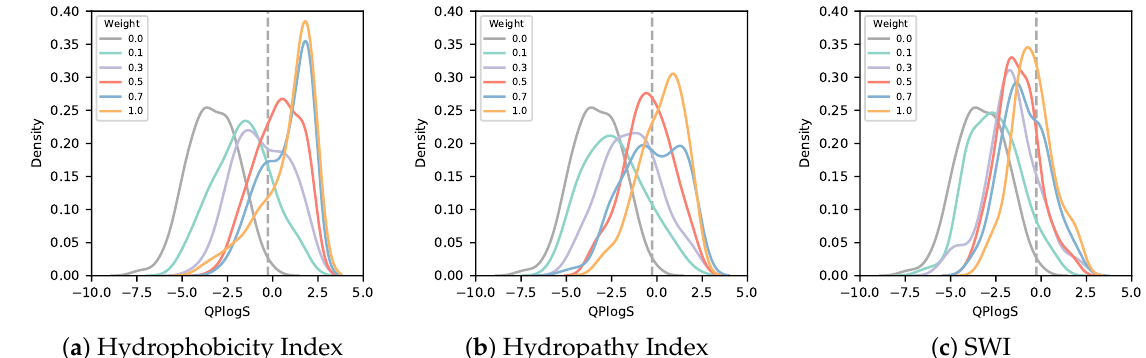
Figure 3. Distribution of logS for various weights of sequences designed in AfDesign using three solubility indices. The logS of sequences designed in AfDesign using the Hydrophobicity Index ( a ), Hydropathy Index ( b ), and Solubility-Weighted Index ( c ) as solubility indices in the loss function. Each color indicates the weight of the solubility loss. The gray line with a weight of 0.0 shows the distribution of logS for the sequence designed by AfDesign without a solubility index. The dashed line shows the logS of the p53 peptide.